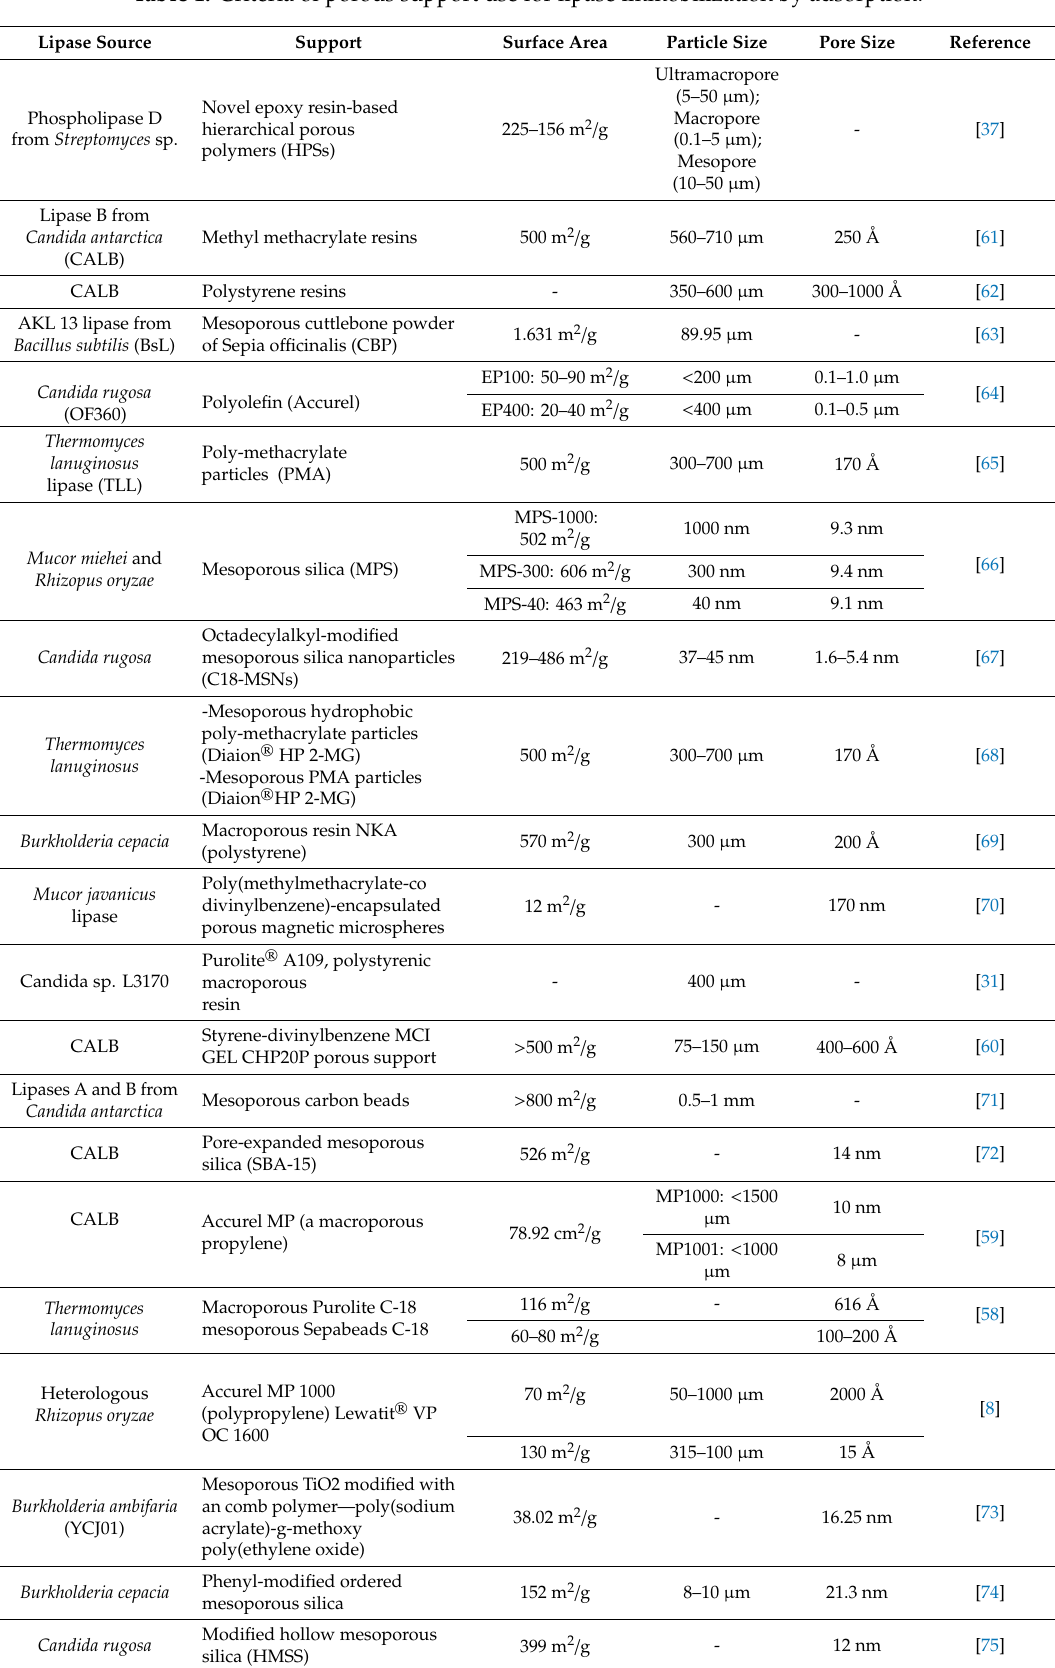
Table 1. Criteria of porous support use for lipase immobilization by adsorption. Lipase